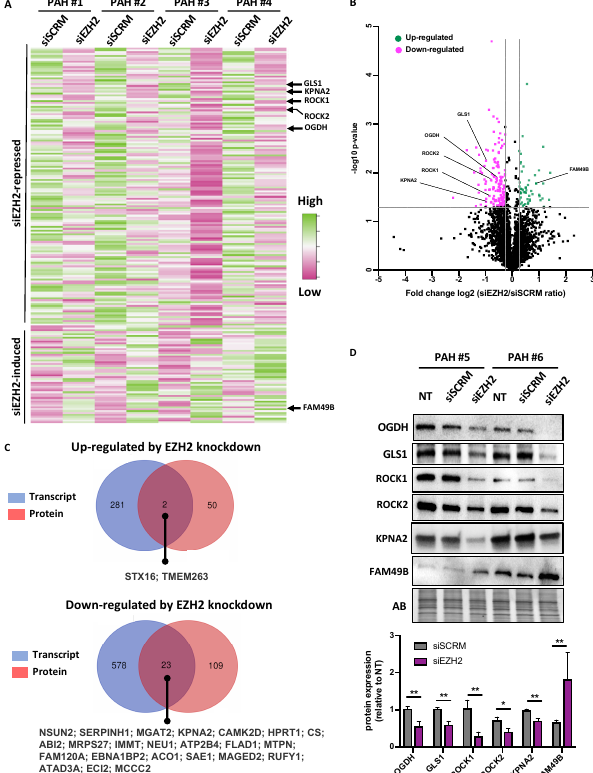
Figure 4. Proteomic analysis of siRNA-mediated silencing of EZH2 in PAH-PASMCs. ( A ) Heatmap representation of all proteins whose expression levels were significantly impacted (FDR < 0.05) after silencing of EZH2 by a fold change > 1.2 or <1.2. The columns represent the results of four independent PAH-PASMC cell lines transfected with siSCRM and siEZH2. Rows show individual differentially expressed proteins. The color key from pink to green represents protein abundance from low to high. Selected proteins are marked on the right side; ( B ) Volcano plot comparing the proteome of siSCRM and siEZH2-treated PAH-PASMCs. Vertical lines indicate a fold change ± 1.2, and the horizontal line is indicative of a paired t-test p -value threshold of 0.05. Pink (downregulated) and green (upregulated) points: transcripts that meet both criteria for significant change (i.e. paired t-test p -value < 0.05 and fold change > 1.5) between control and EZH2 depleted cells; ( C ) Venn diagrams showing the numbers of common and unique differentially expressed genes (blue) and differentially expressed proteins (red) found to be significantly up- and down-regulated upon EZH2 knockdown in PAH-PASMCs; ( D ) Validation of proteomic results by Western blot. Representative immunoblots and corresponding densitometric analysis of selected proteins (OGDH, GLS1, ROCK1, ROCK2, KPNA2, and FAM48B) in PAH-PASMCs ( n = 6–10) subjected or not to EZH2 knockdown for 48 h. Protein expression was normalized to Amido black (AB). Data are presented as mean ± SEM; * p < 0.05 and ** p <